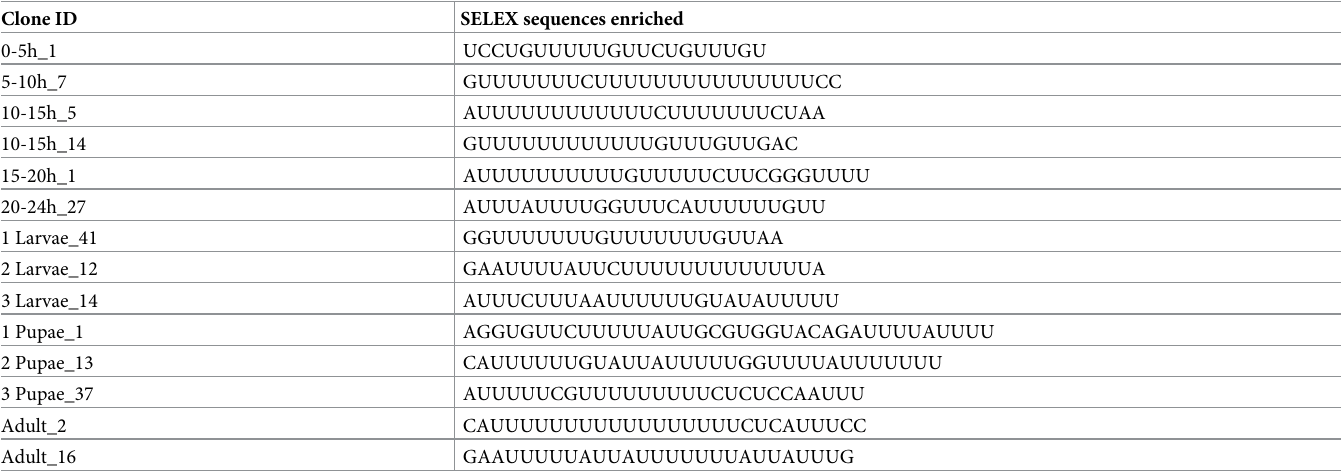
Table 2. Sequences of the SXL- binding sites from the cDNA libraries.